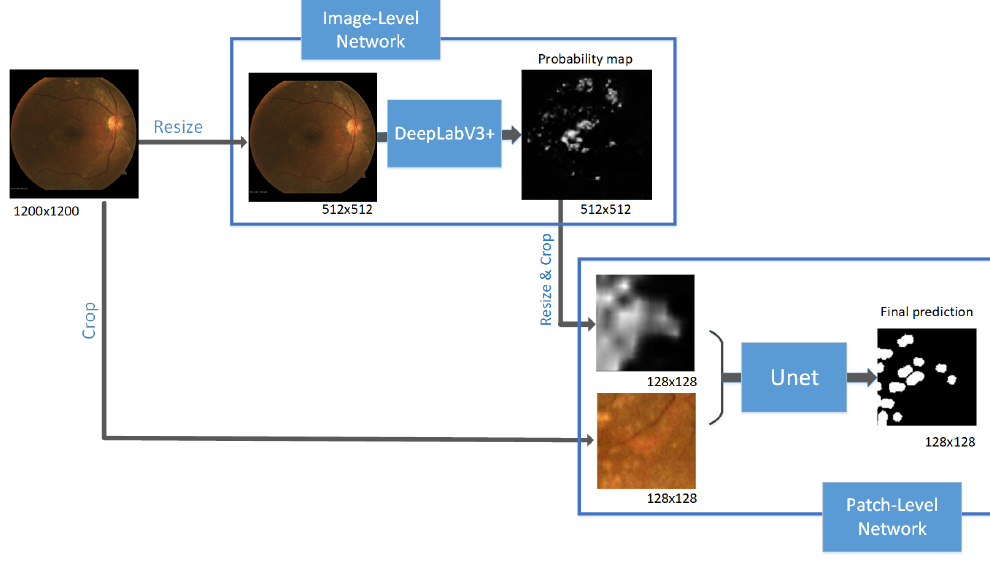
Figure 2. The proposed multi-scale model for drusen